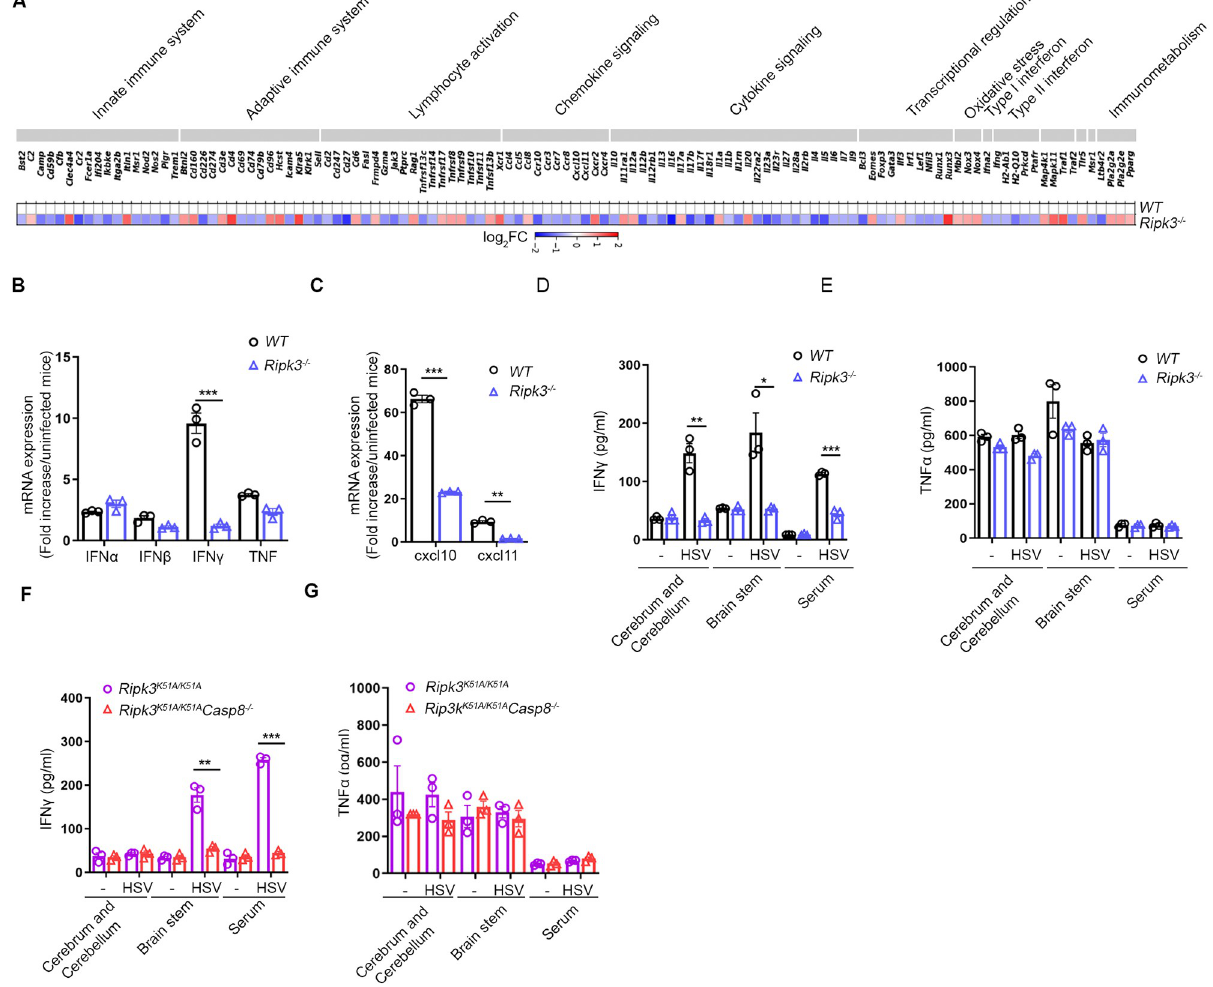
Fig 4. Impact of RIPK3 on tissue cytokine levels. (A) Heat map comparing mRNA patterns of immune-related genes in brain from WT and Ripk3 −/− mice (n = 3 for each group) at 5 dpi, where mean fold-change of each transcript was compared to normalized expression of all WT immune-related transcripts. Blue, white and red indicate down-regulated, unchanged and up-regulated expression, respectively. (B and C) mRNA levels of IFNs, cxcl10, cxcl11 were measured by qRT-PCR in brain homogenates of WT and Ripk3 -/- mice. (D and E) Levels of IFN γ and TNF were measured by ELISA in combined cerebrum and cerebellum or brainstem homogenates as well as serum of WT and Ripk3 -/- mice. (F and G) Levels of IFN γ and TNF were measured by ELISA in cerebrum and cerebellum, brainstem homogenates as well as serum of Ripk3 K51A/K51A and Ripk3 K51A/K51A Casp8 -/- mice (n = 3 per group). � P < 0.05; �� P < 0.01; ��� P <